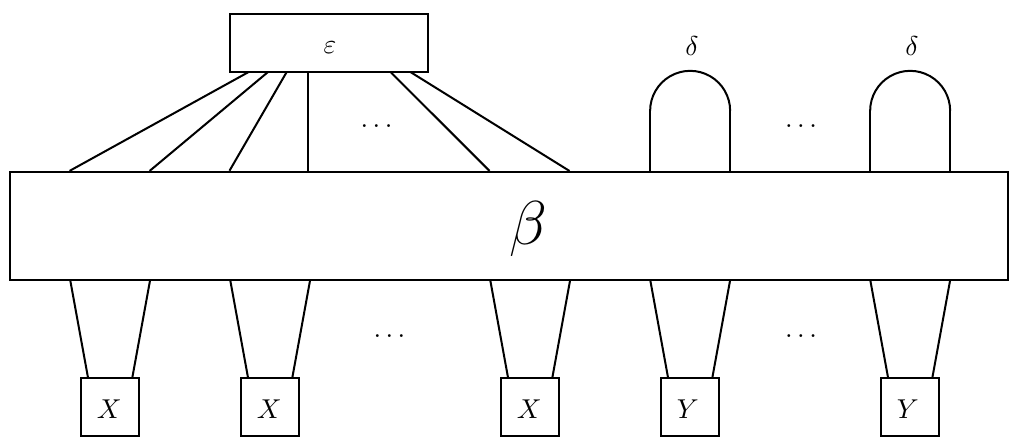
(cid:0) (cid:1) = n + m (cid:0) N (cid:14) s. For convenience, this 2